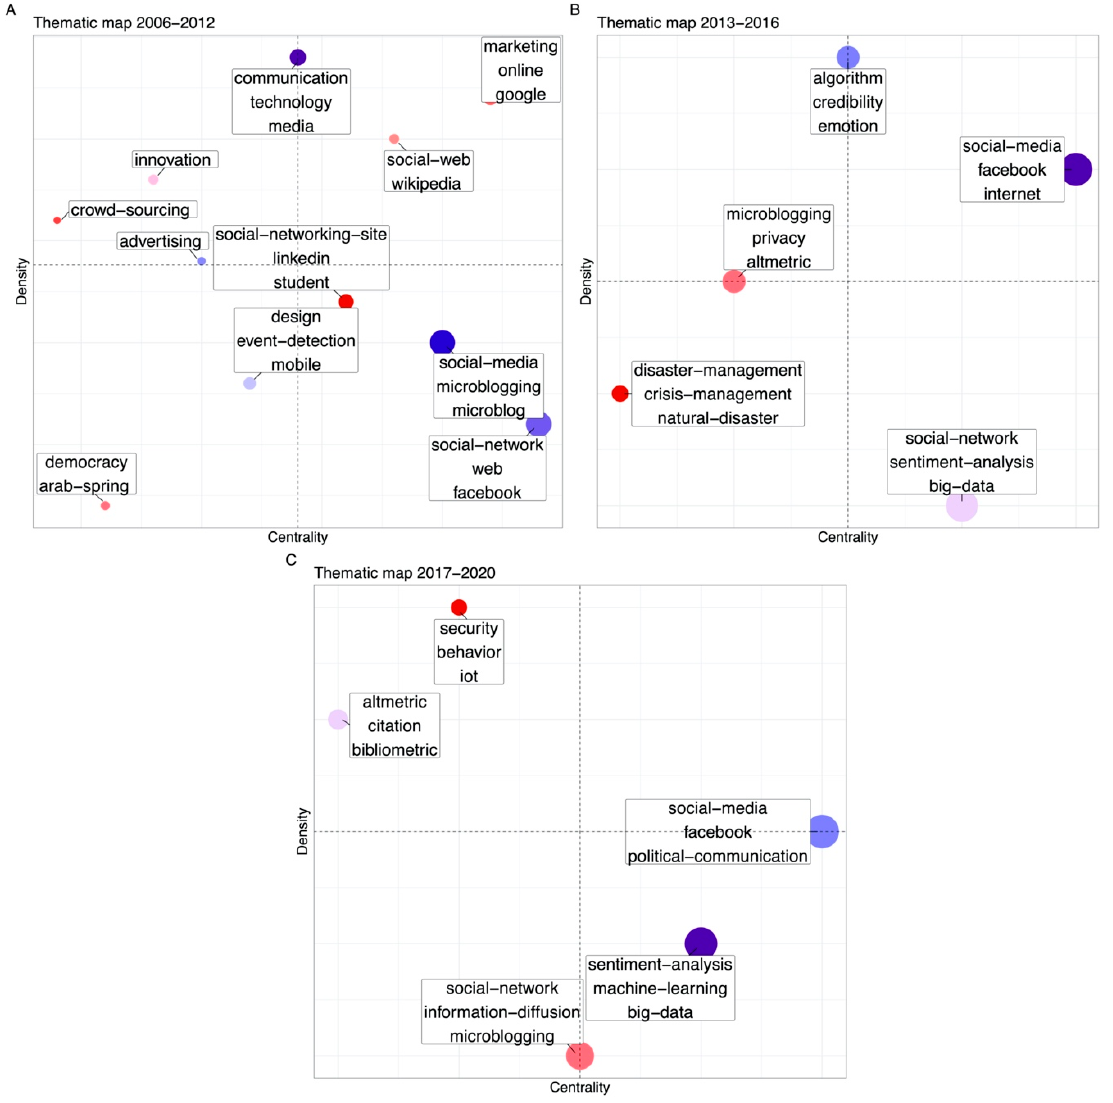
Figure 6. Thematic maps of the three periods. ( A ) Initial period, ( B ) developing period and ( C ) advanced period.